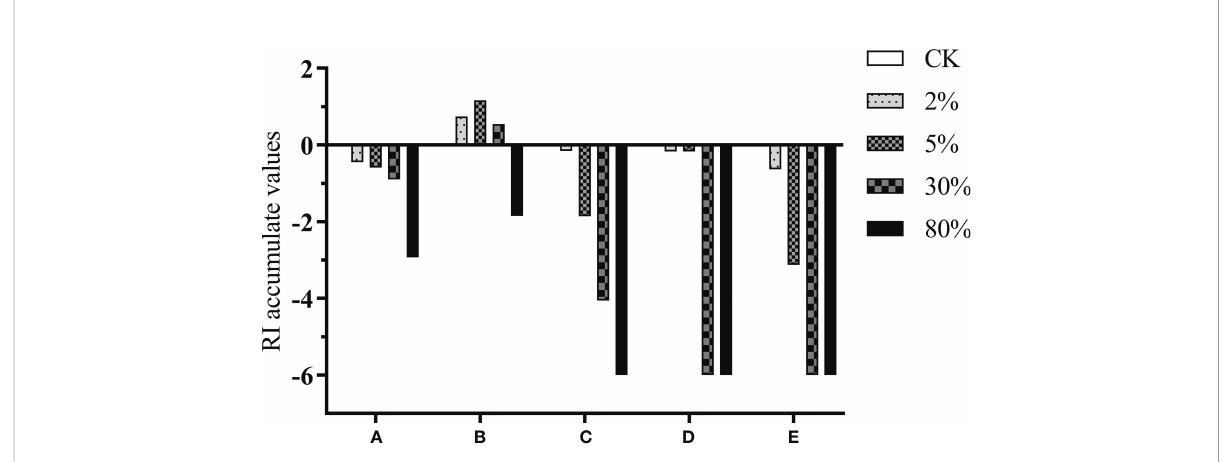
FIGURE 2 RI accumulation value of different identi fi ed substances on germination and growth of goosegrass. (A) 4-Ethylphenol. (B) Allyl isothiocyanate. (C) N-acrylimorpholine. (D) 2-hydroxyethyl acrylate. (E) Mixture of (A) to (D)